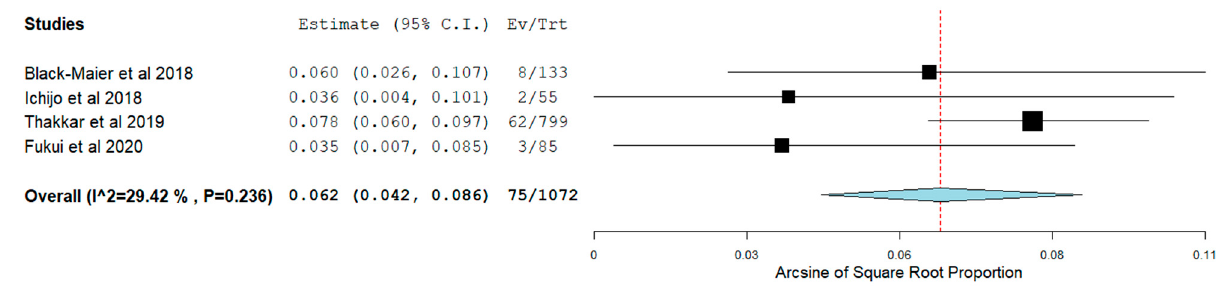
Figure 5. HF admissions in patients with HFpEF.